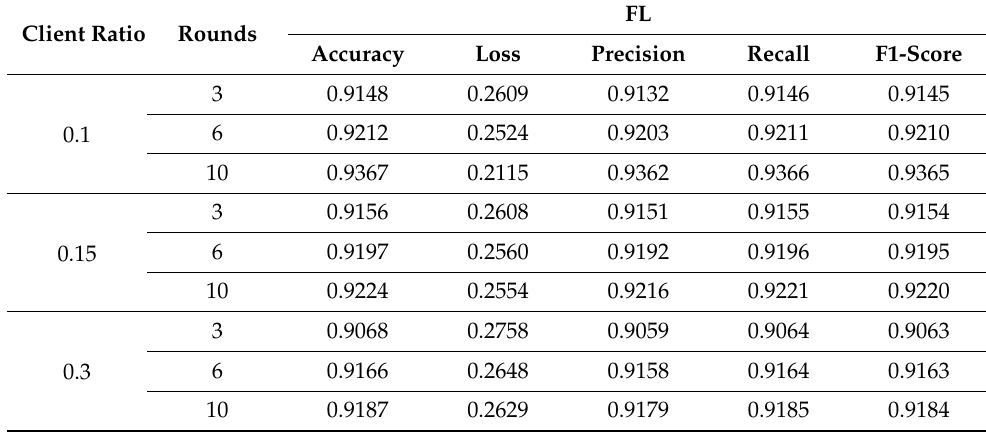
Table 4. Comparison of the performance of FL on various hyper-parameters on the COVID test data.